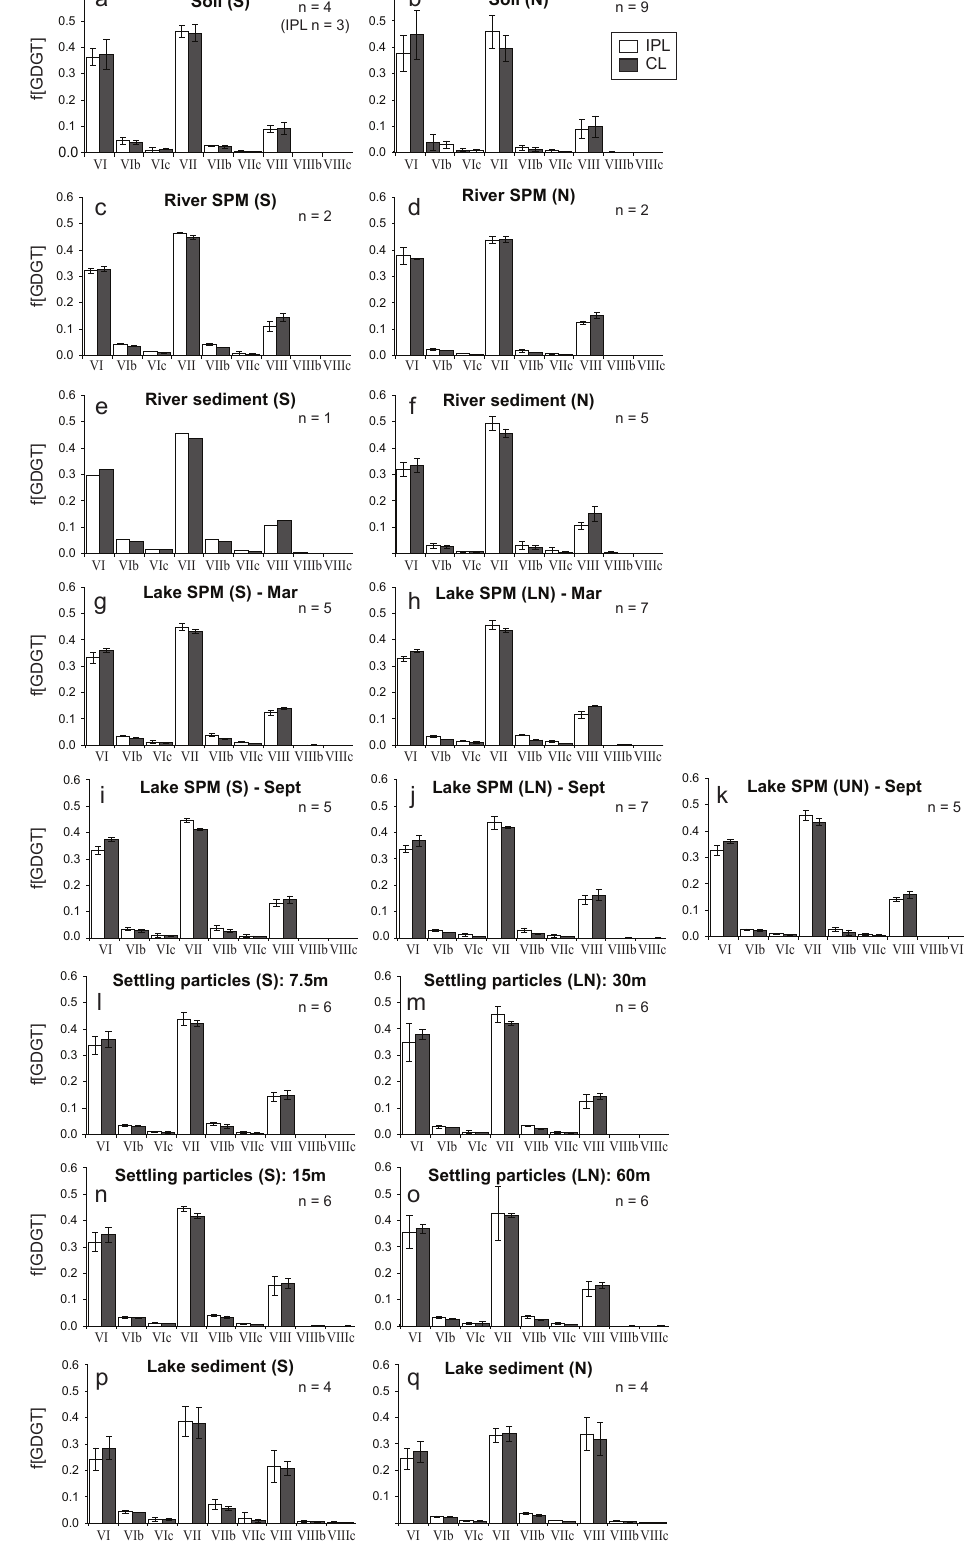
Figure 5. Bar plots (a–q) representing averaged IPL and CL brGDGT distributions in sample groups by basin and, in the case of settling particles, by the depth of collection. Errors are equal to 1 σ